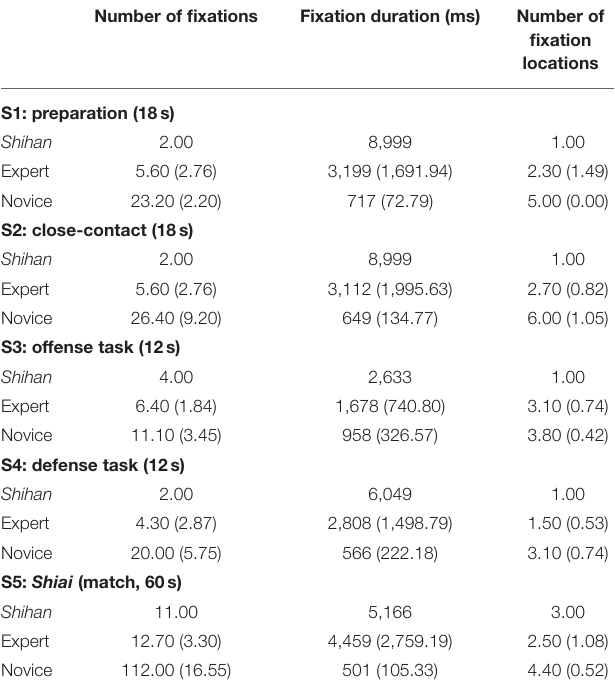
TABLE 2 | Mean (SD) number of fixations, mean fixation duration, and mean number of fixation locations per trial across groups in all sessions (trial